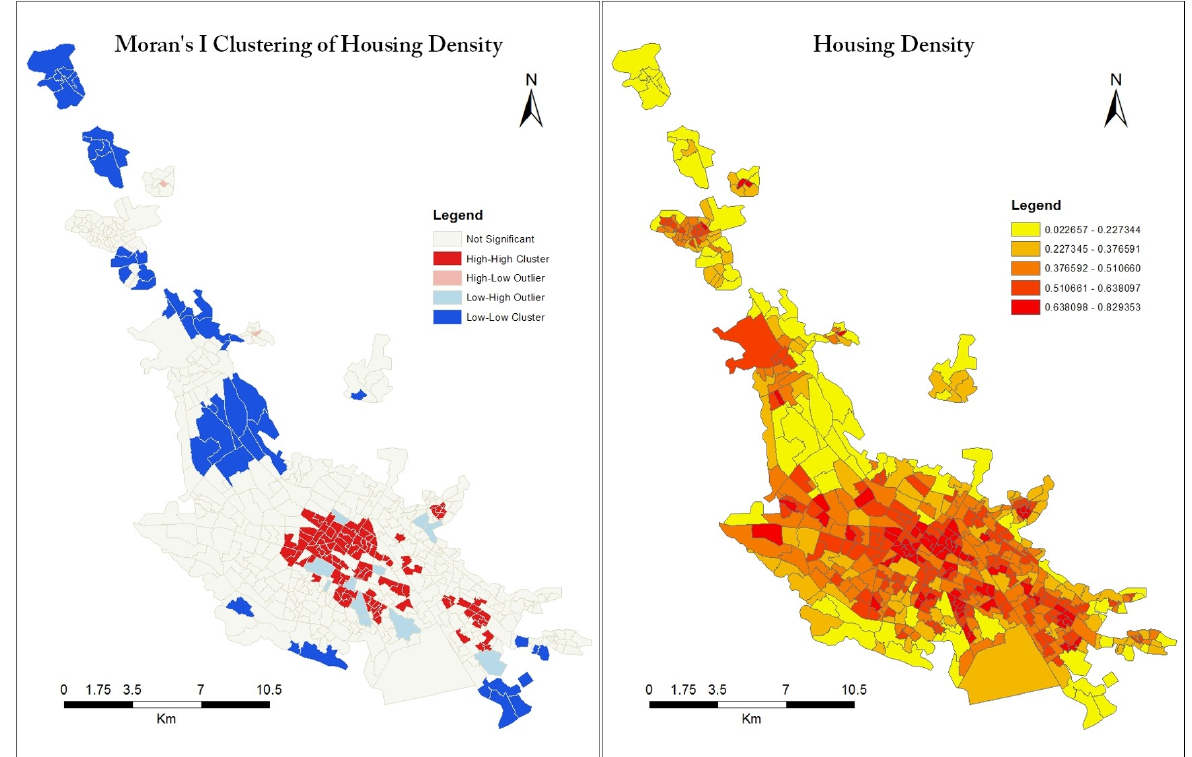
Figure 8. Housing density distribution in the case of Shiraz.